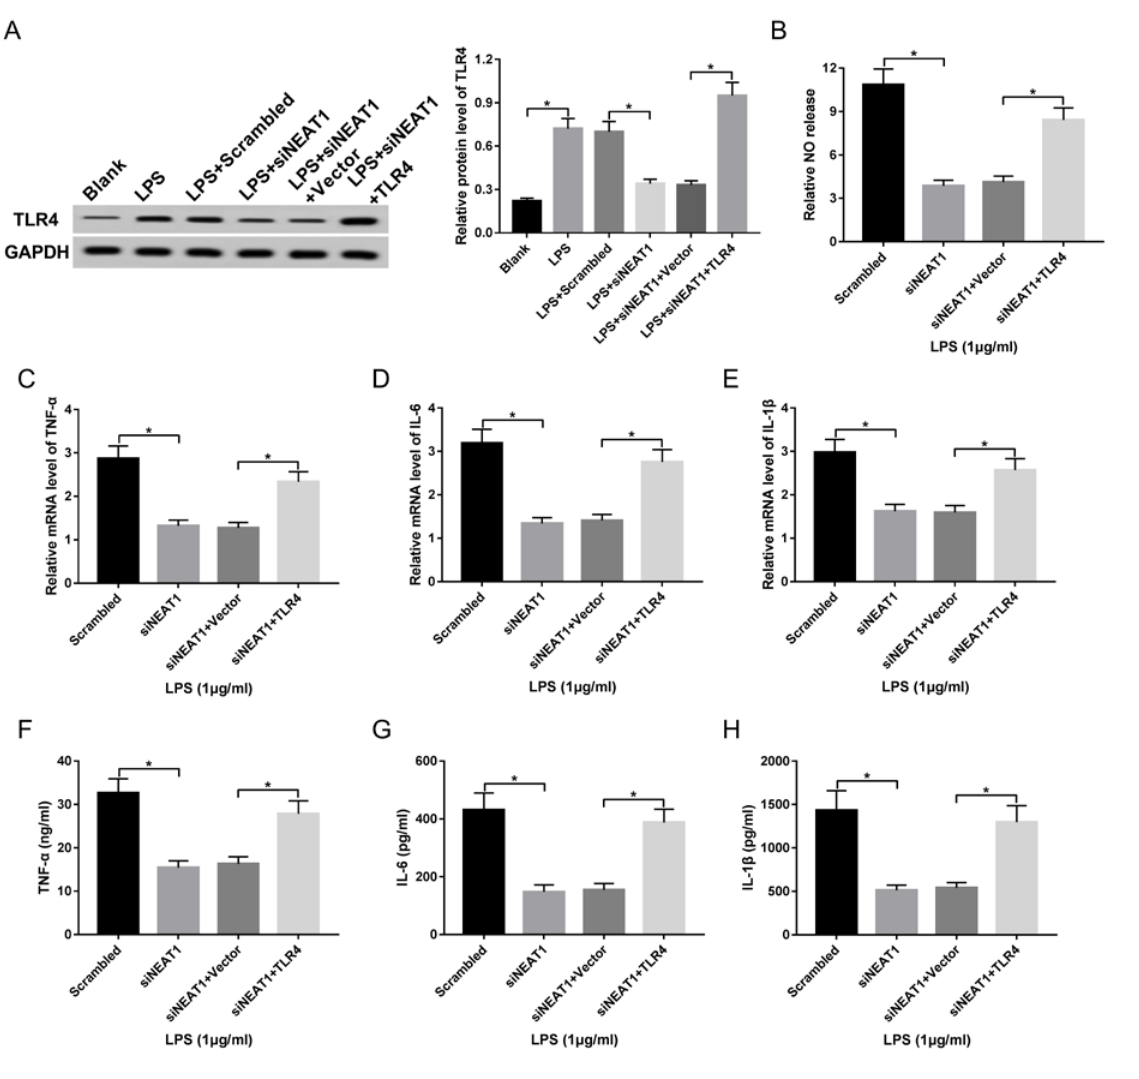
Figure 6: TLR4 reverses silence of NEAT1-mediated inhibition of LPS-induced injury in macrophages. Cells were transfected with scrambled, siNEAT1, siNEAT1 and vector or TLR4 and then treated with LPS. TLR4 protein level (A), NO release (B), and inflammatory cytokine expression (C-H) were measured in the cells.